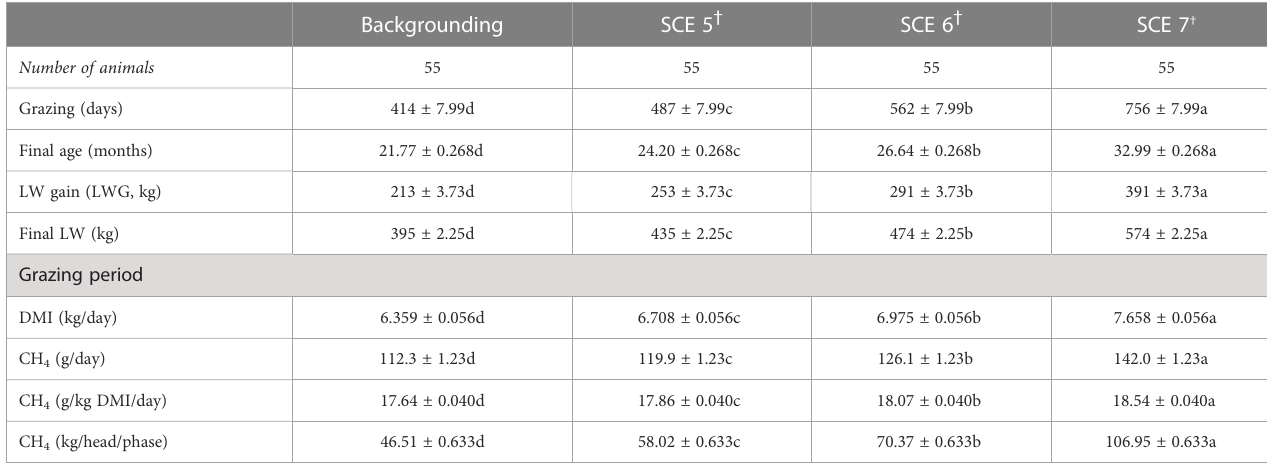
TABLE 3 Estimated animal performance and methane (CH 4 ) emissions of growing commercial Brahman ( Bos indicus ) stockers-yearlings steers on Brachiaria decumbens pastures associated with a common daily liveweight gain (LWG) of 0.516 kg and three processing target LW scenarios (SCEs).